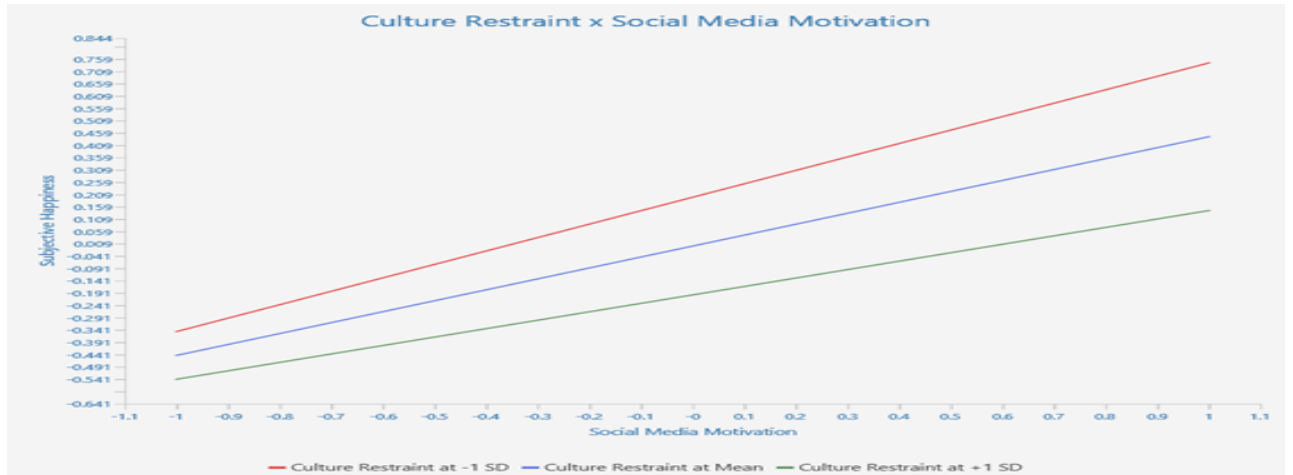
Figure 4. Moderating effect of cultural restraint on the relationship between social media motivation and subjective happiness.